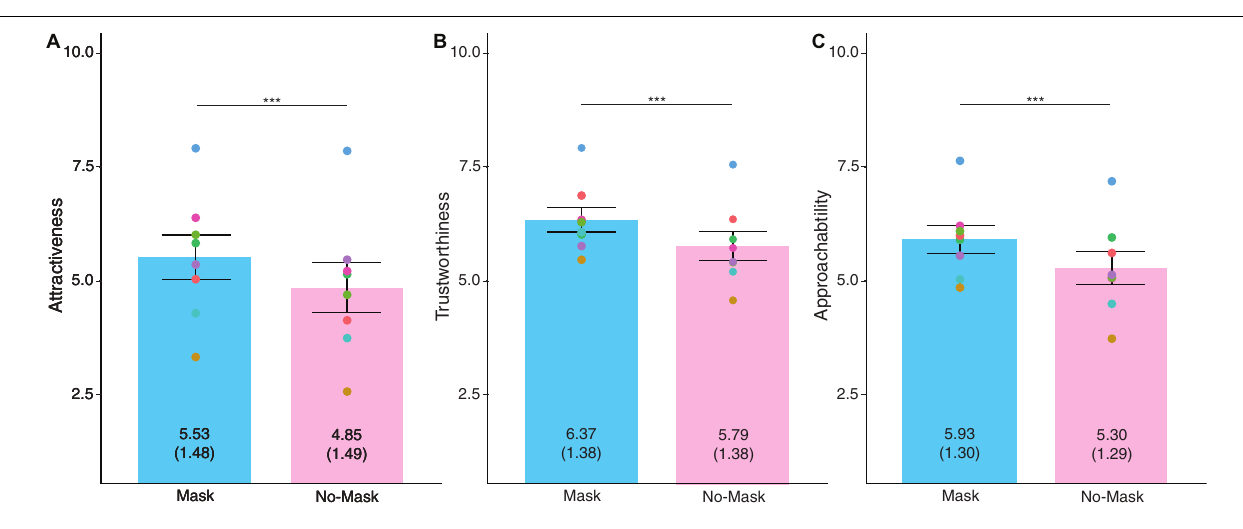
Bonferroni-corrected α = 0.017. Neutral expressions were also rated happier than sad expressions, t (989) = 61.71, SD = 1.10, p < 0.001, Bonferroni-corrected α = 0.017. This indicated that the participants attributed the emotional expressions correctly.